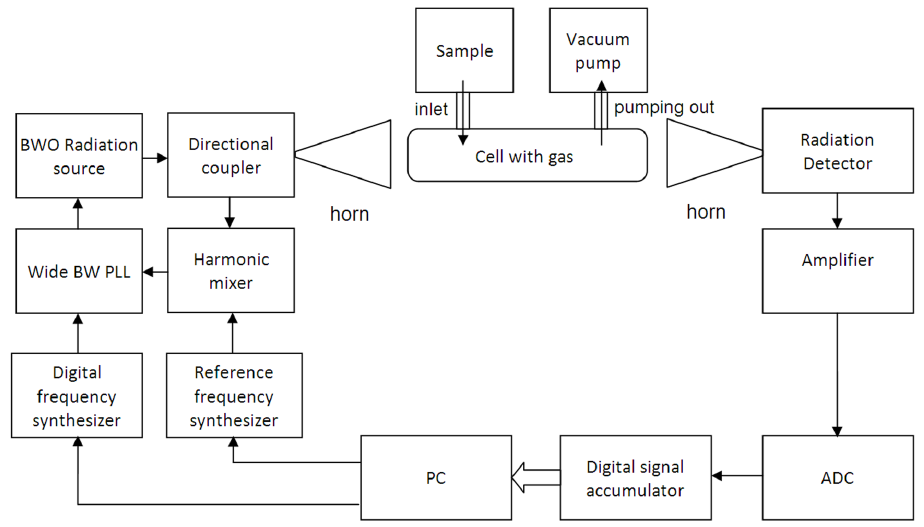
Figure 2. The scheme of a fast frequency sweep spectrometer, where PC is a personal computer and ADC is an analogue-to-digital converter.